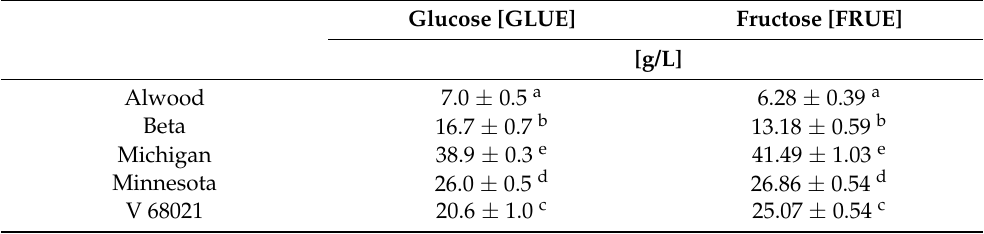
Lower-case letters mean values in the columns are significantly different at p ≤